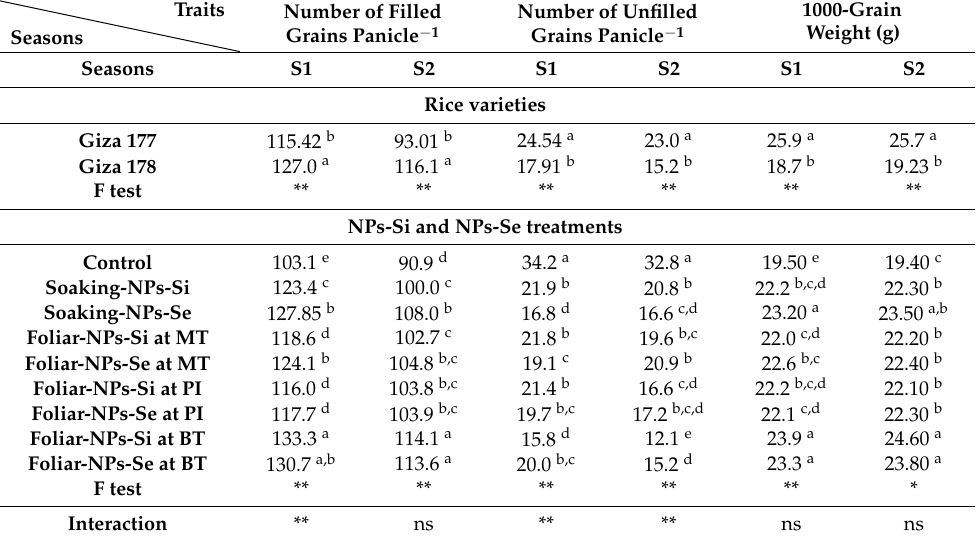
Table 7. Effect of NPs-Si and NPs-Se treatments on number of filled grains/panicle, number of unfilled grains/panicle, and 1000 grain weight of two rice varieties under saline soil conditions in the 2018 (S1) and 2019 (S2) seasons.